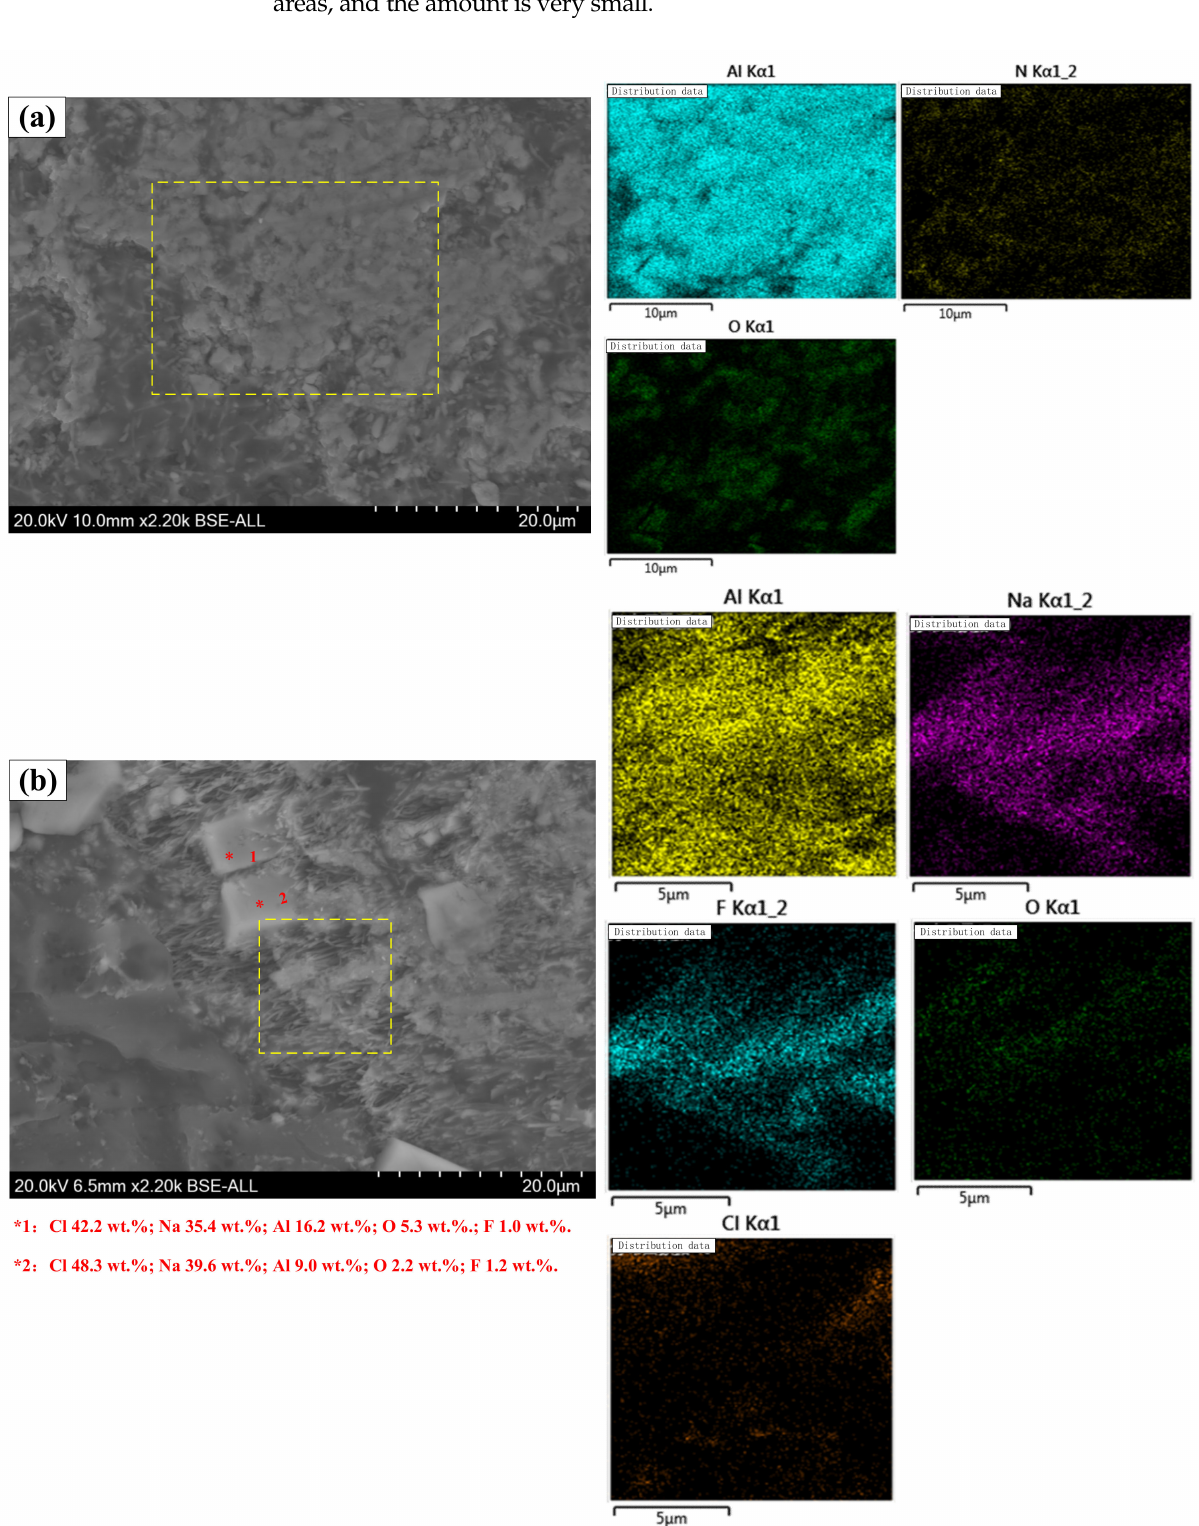
Figure 9. BSE micrographs of typical phases in original secondary aluminum dross, ( a ) phases of Al 2 O 3 and AlN coexistence, ( b ) Na 3 AlF 6 phase and NaCl